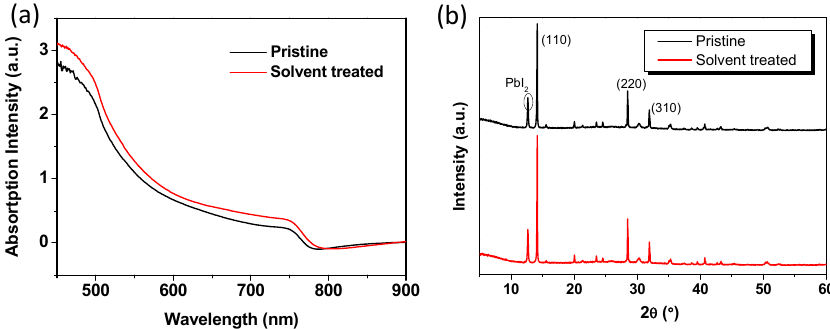
Figure 5. UV-vis and XRD spectra of ( a ) pristine and ( b ) DMSO solvent washing treated PEDOT:PSS based perovskite films.